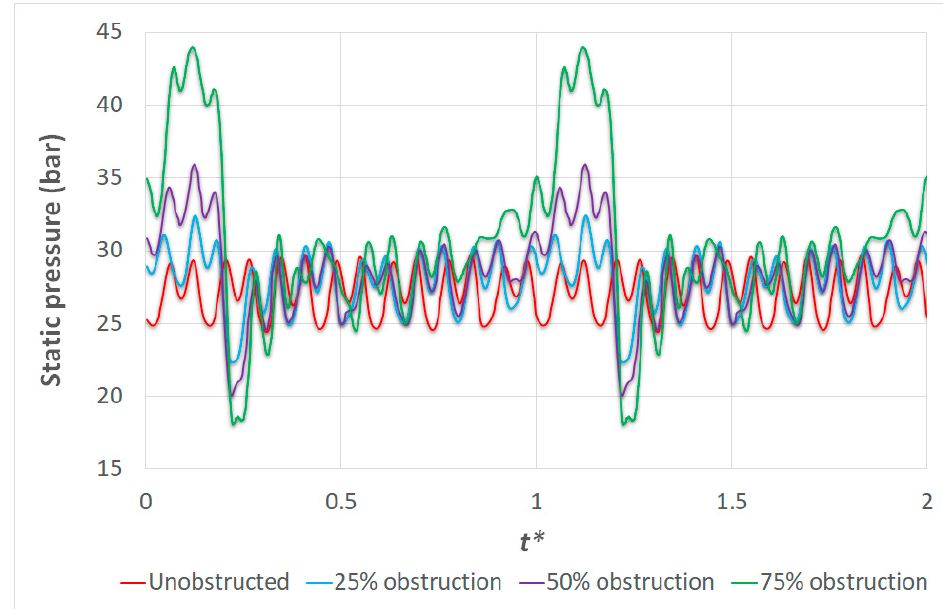
Figure 12. Pressure signal in the inertial reference frame (monitor point E3) for different rotor blockage sizes.